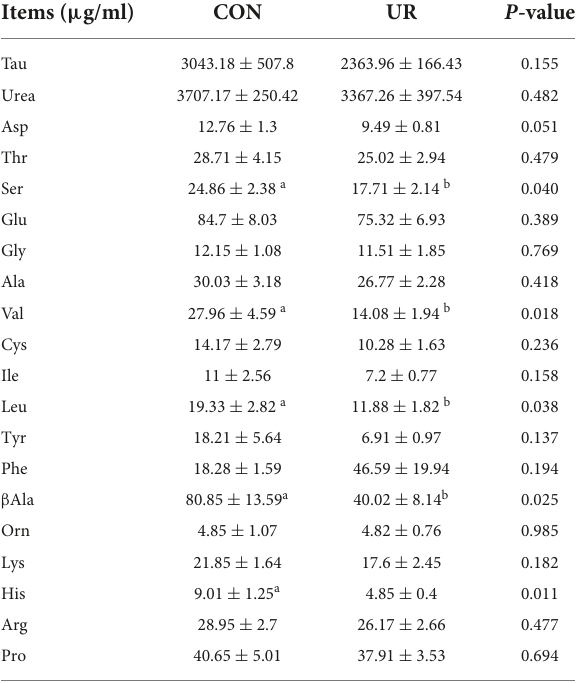
TABLE 6 Effects of UR on free amino acids profile in colostrum.